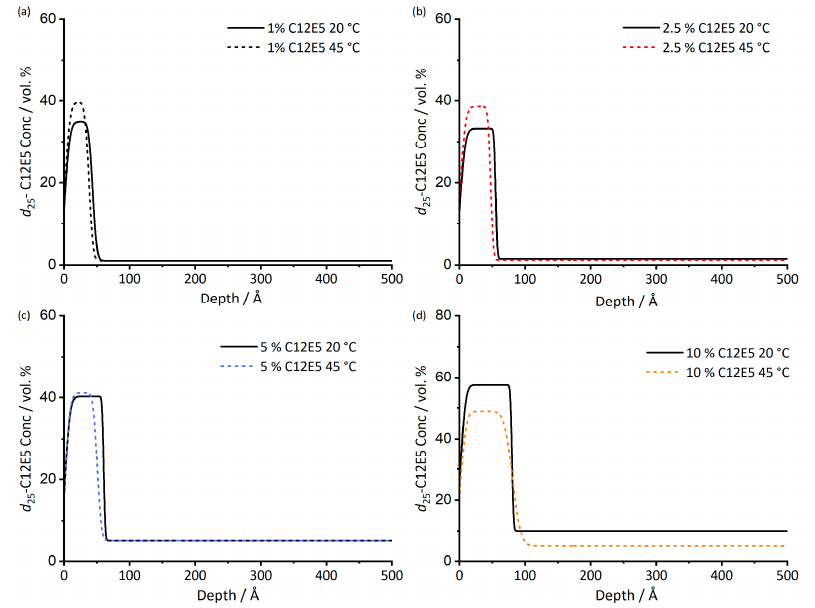
Figure 2. Depth profile of d 25 -C 12 E 5 in cis -PI films at both 20 and 45 °C. The depth profiles are determined from the scattering length density profiles of the films. Surfactant loadings are 1 % (a), 2.5% (b), 5% (c), 10 % (d). Fitted data used to obtain 45 °C depth profiles are given in Figure S5.